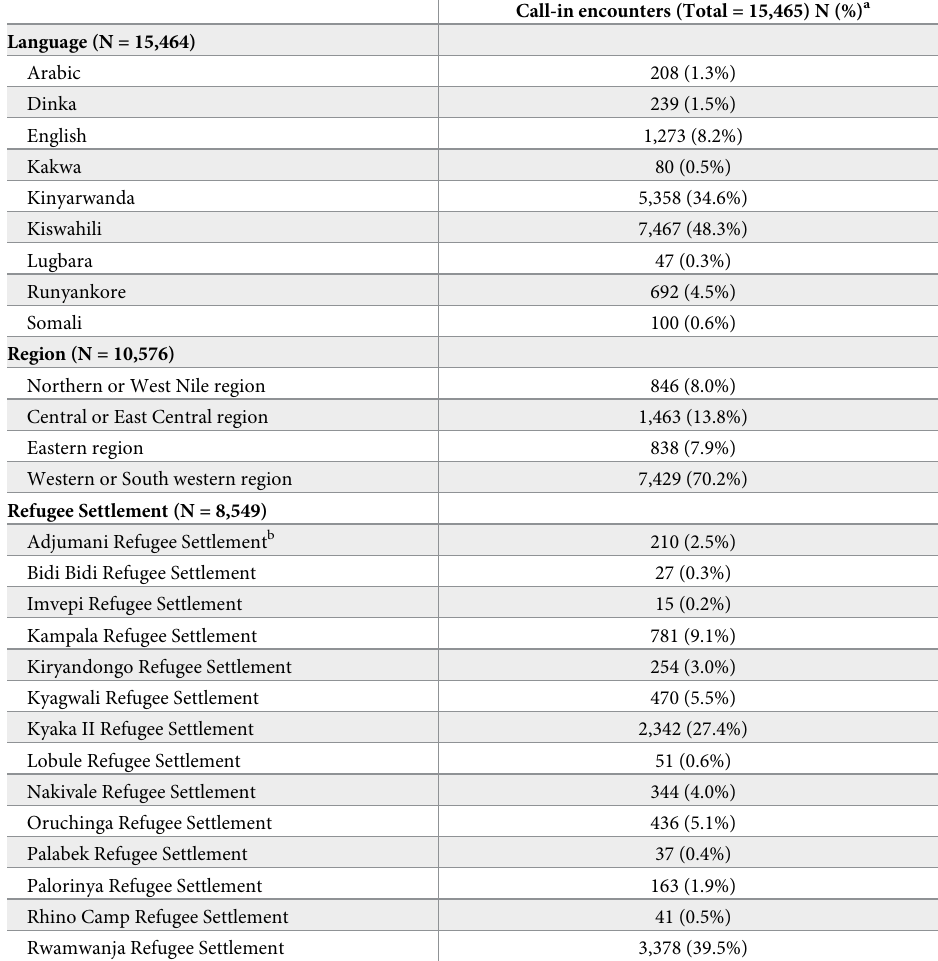
Table 1. Language and geographic distribution of Dial-COVID call-in